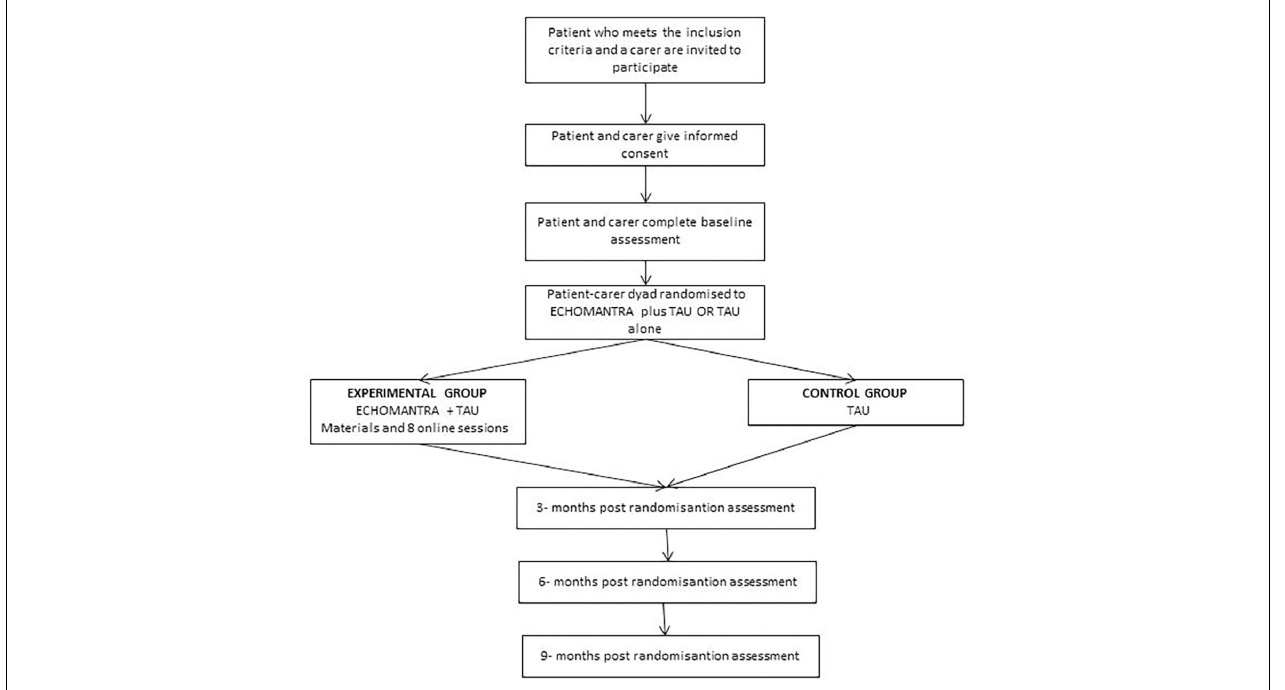
FIGURE 1 | Study design flow